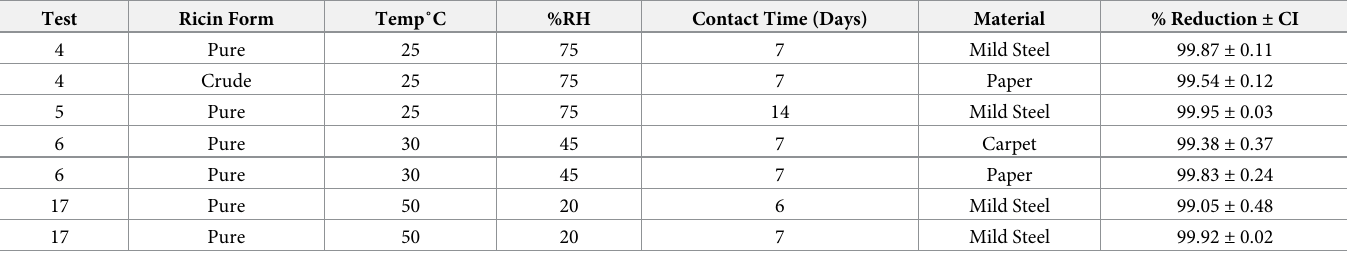
Table 2. Test parameter combinations demonstrating greater than 99% reduction of